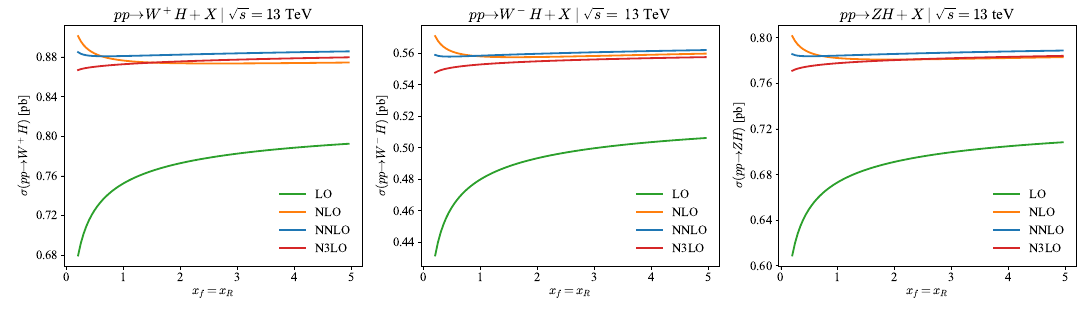
Figure 15 . Scale dependence for the associated Higgs production for a fixed central scale choice µ 0 = m V + m H . We vary the factorization and renormalization scale in a correlated fashion by varying the parameters x and x simultaneously (see main text). F R